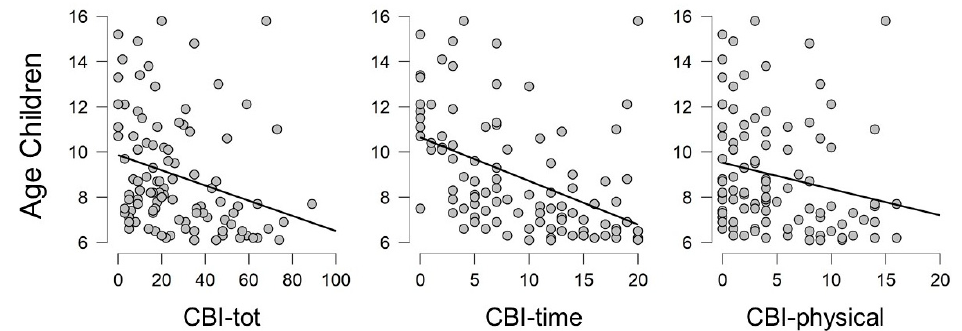
Figure 4. Graphic representations of negative correlations between the age of children and the level of caregiver’s